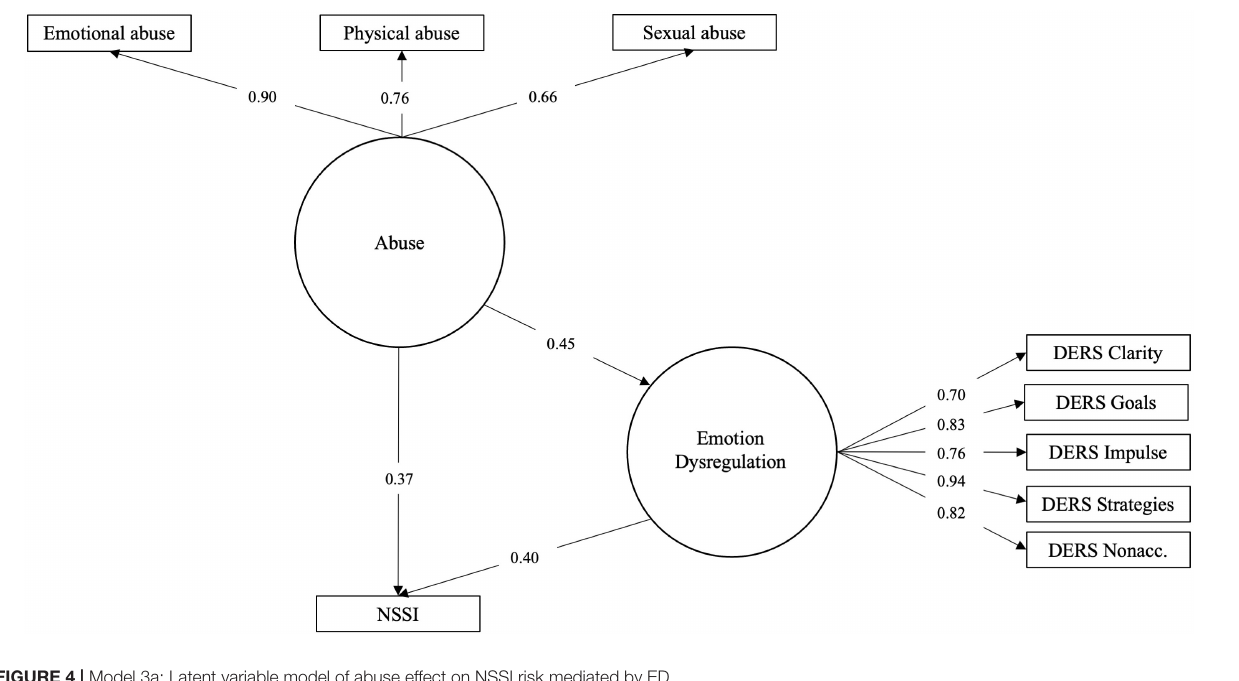
FIGURE 4 | Model 3a: Latent variable model of abuse effect on NSSI risk mediated by ED.